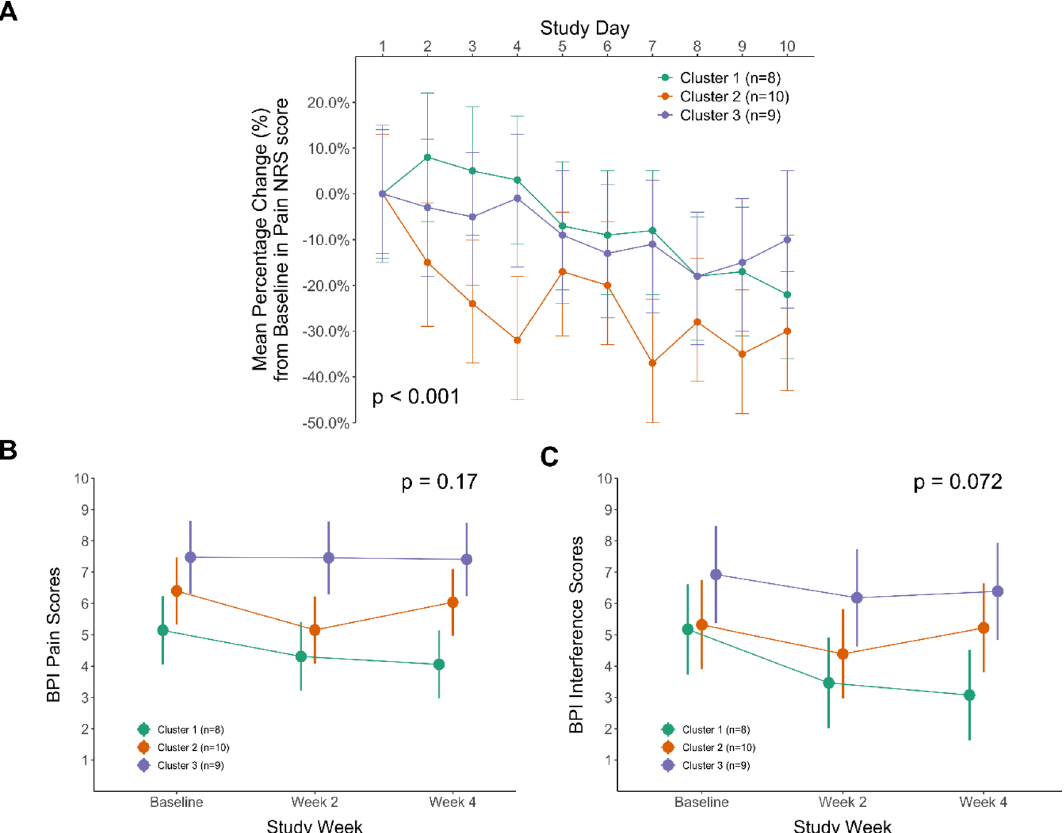
random intercept for individual participants. Points and Bars represent least square means and 95% confidence intervals,